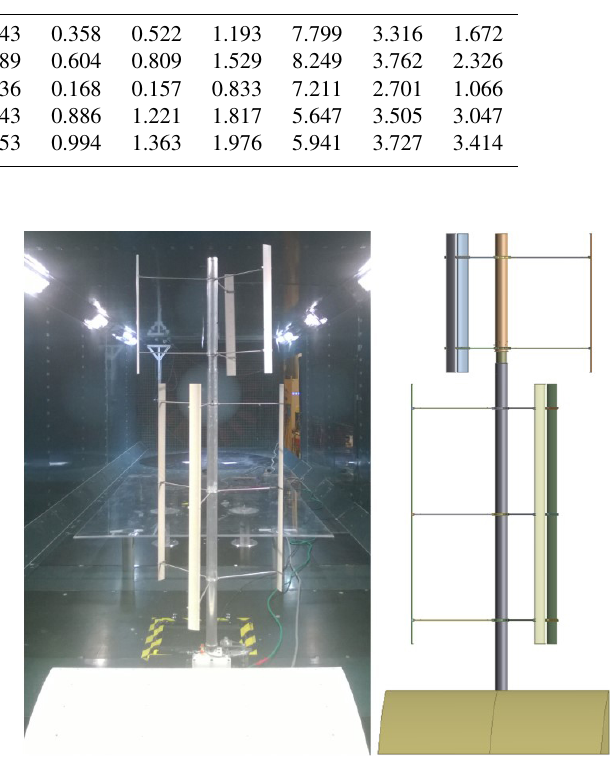
Figure 6. Model set in configuration